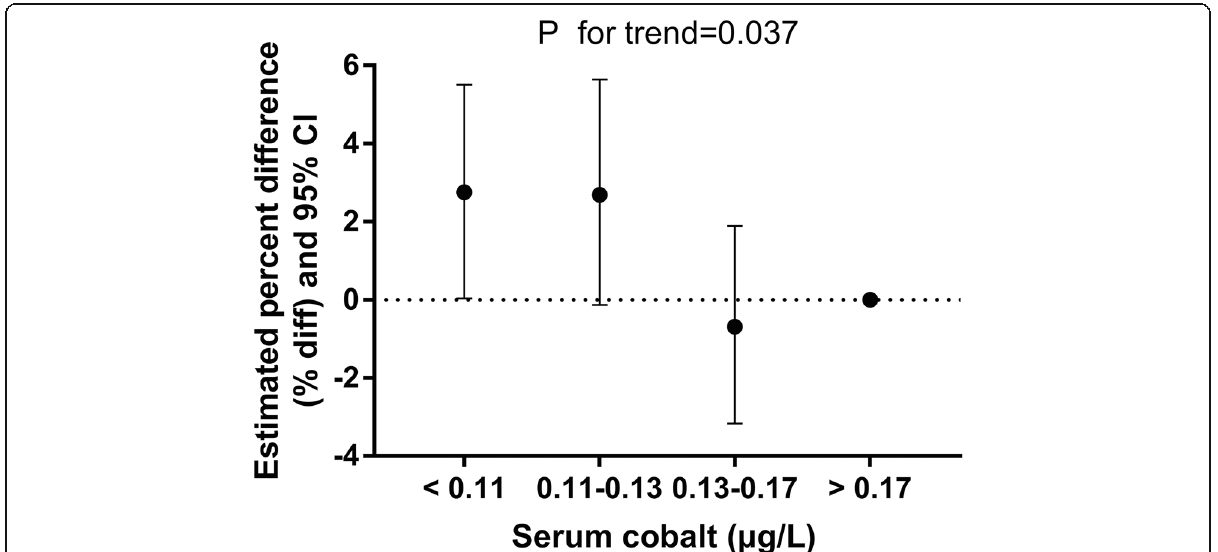
Fig. 2 Estimated percent difference (% diff) and 95% confidence intervals (95% CI) in HOMA-IR in US adults during 2015 – 2016 for each interquartile ratio (IQ ratio) increase in blood cobalt